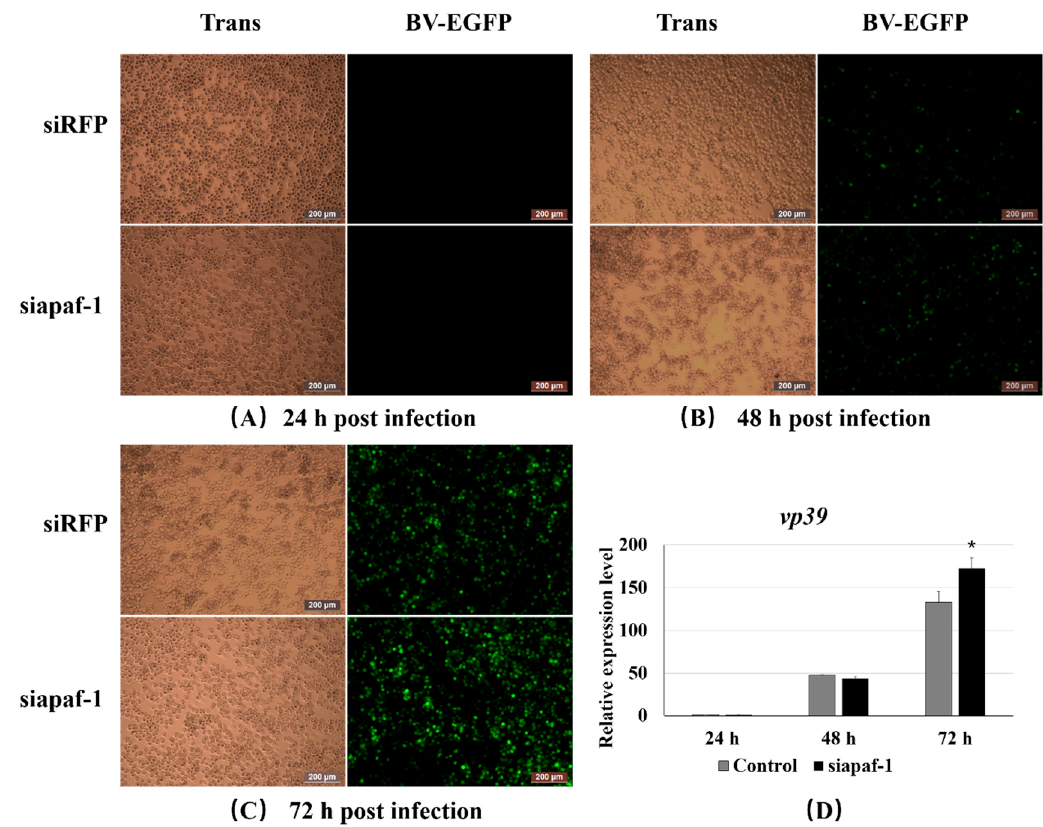
Figure 4. Analysis of BmNPV infection following knockdown of Bmapaf-1 at different times in BmN cells: 24 h ( A ); 48 h ( B ), and 72 h ( C ) after BV-EGFP infection. ( D ) The analysis of vp39 expression after knockdown of Bmapaf-1 at different times. Scale bar = 200 μ m. Trans (white), optical transmission. EGFP (green), expressed following the replication of BV. BmGAPDH was used to normalize the data that were showed as the mean ± standard error, the mean was from three independent repeats. The 2 − △△ Ct method was adopted to calculate the relative expression level. Differences among triple repeats were analyzed using the SPSS Statistics 20 software (IBM, USA) with the one-way ANOVA method. Asterisks represent the significant difference, * p < 0.05.